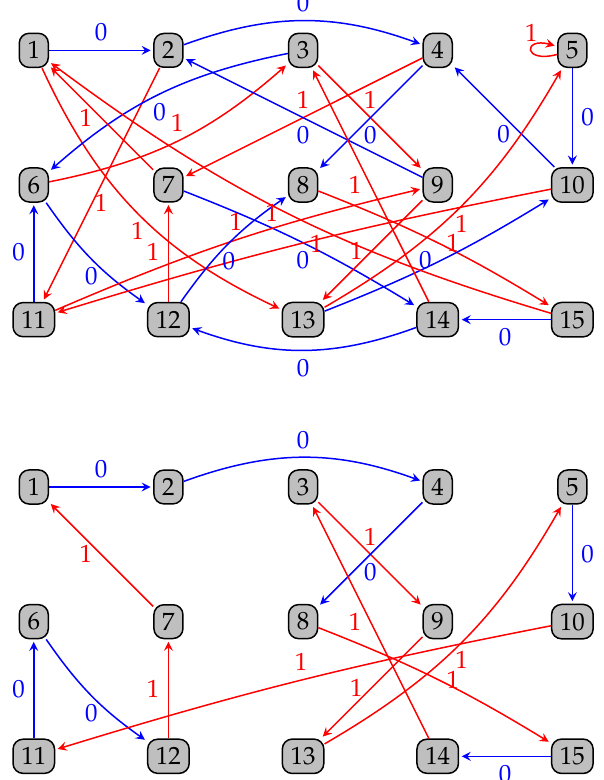
Figure 1. ( Top ): The graph Γ 4 with blue arcs based on (18) and red arcs based on (19). ( Bottom ): A Hamiltonian cycle H in Γ 4